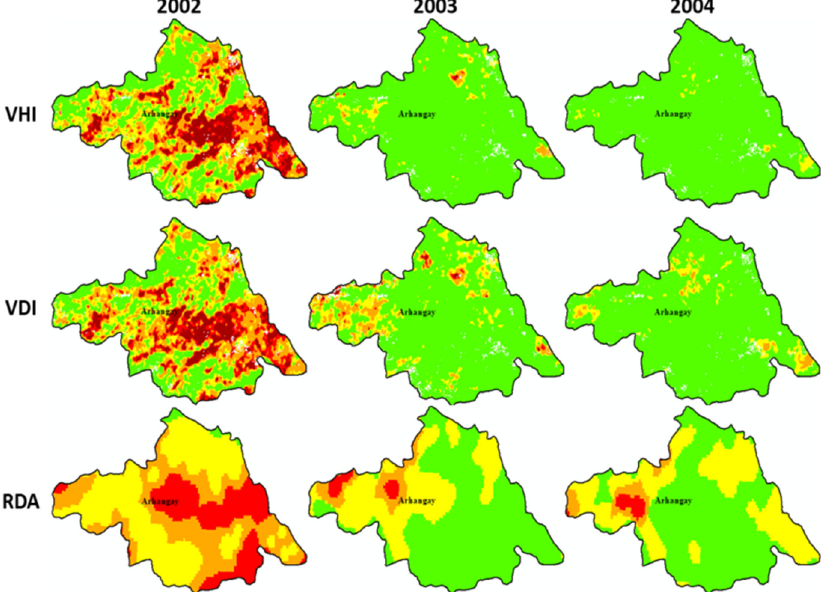
Figure 4. Drought distribution maps of the VHI, VDI, and field-based RDA in the first dekad of each July from 2002 to 2004 for Arhangay Province.